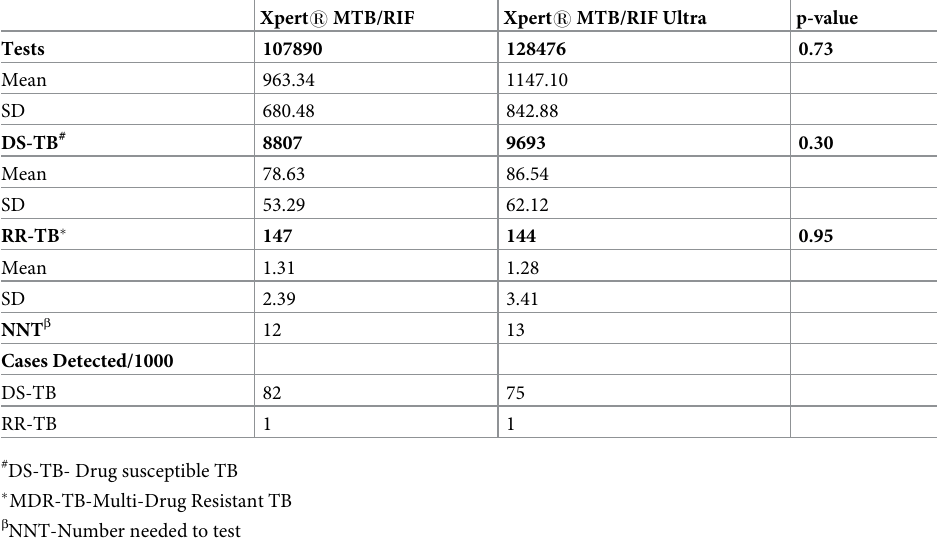
Table 2. A comparison of tests, Drug Susceptible Tuberculosis (DS-TB) and Multi-Drug Resistant TB (MDR-TB) cases detected by Xpert 1 MTB/RIF and Xpert 1 MTB/RIF Ultra assays. Xpert 1 MTB/RIF Xpert 1 MTB/RIF